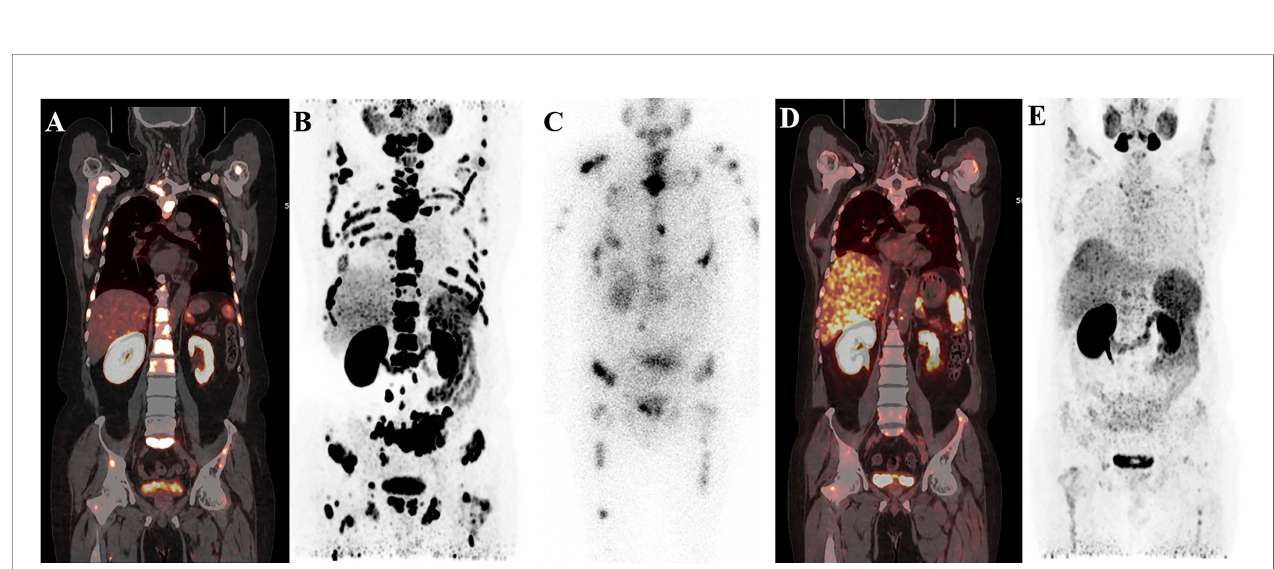
FIGURE 5 | A 58-year-old patient with mCRPC with multiple systemic metastases. Baseline (A, B) 68 Ga-PSMA-11 PET/CT image showing sclerotic bone metastases with higher PSMA expression. Post-therapy image (C) showing higher accumulation of 177 Lu-PSMA-I&T in primary and metastatic lesions. Post- treatment image (D, E) showing extensive osteogenic bone metastases throughout the body, and reduced expression of PSMA compared with before therapy, but some weak remaining PSMA expression, suggesting that the treatment was effective.